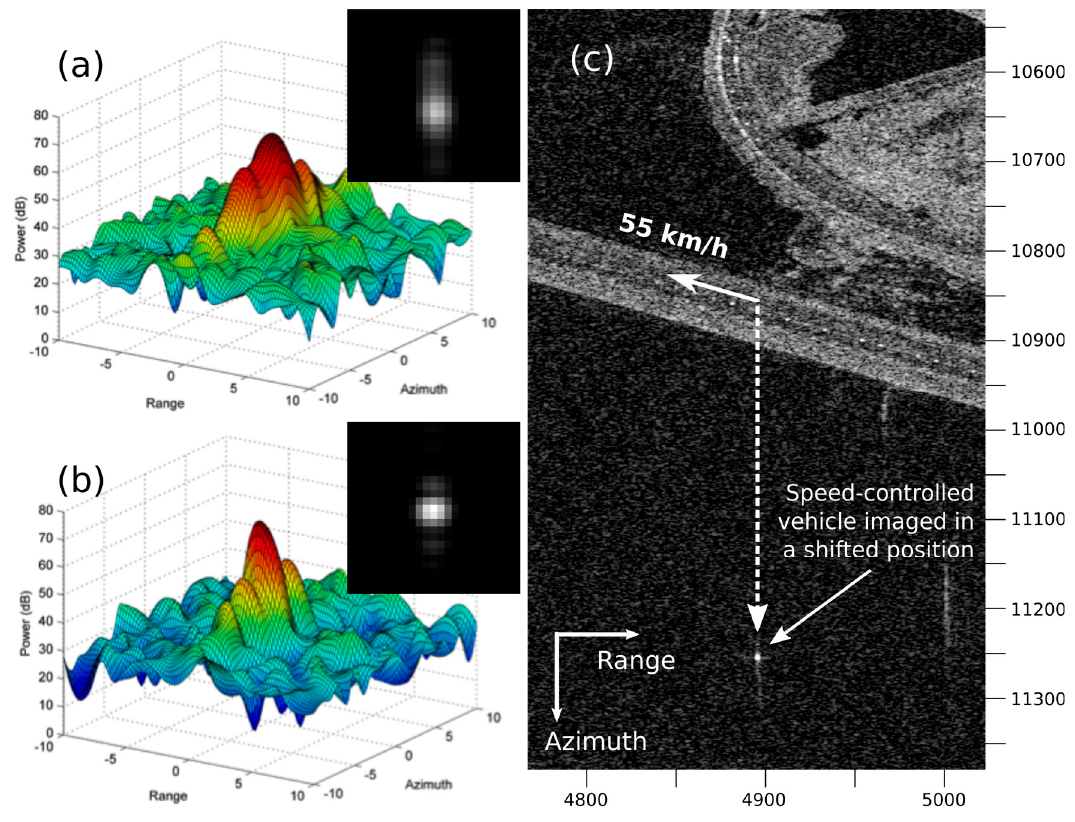
Figure 7. Sub-window image and power distribution of ( a ) the original SLC data and ( b ) the data after removing the residual phase. ( c ) The test was carried out using a speed-controlled vehicle moved with velocities of − 6.6 and − 13.8 m/s (or − 23.8 and − 49.6 km/h, respectively) in the azimuth and range directions, respectively [45]. Note the improvement of symmetry around the target as well as improvement of the compression ratio and peak sidelobe ratio by about 4 dB.